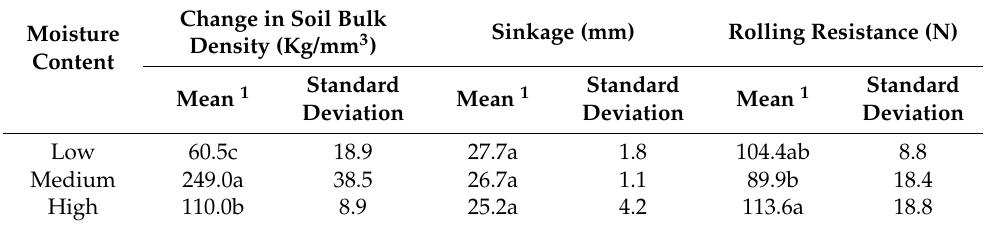
Table 2. Mean values of the variables measured in the soil bin experiment at different soil